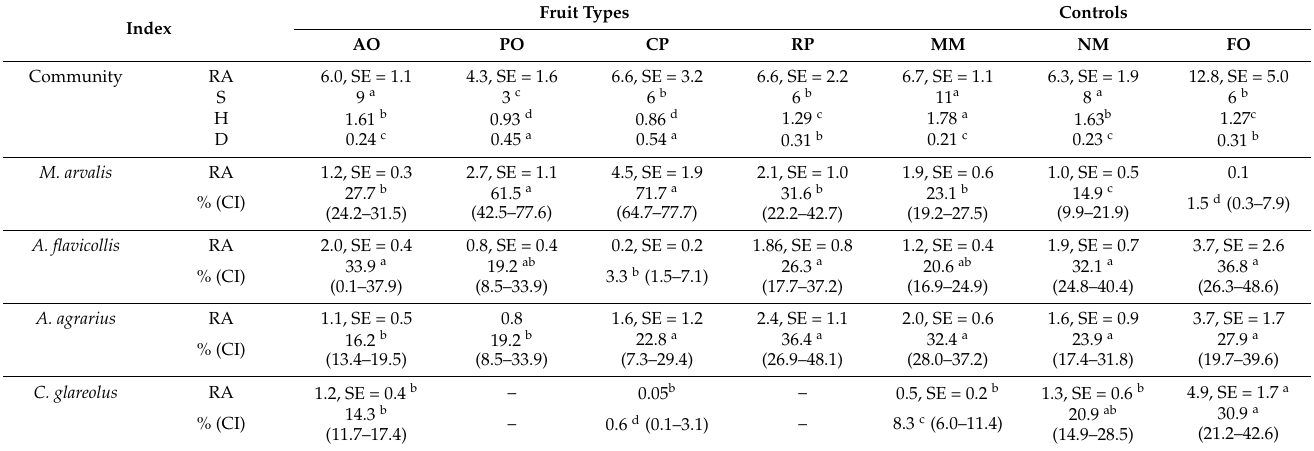
Table 4. Habitat-based differences of analyzed small mammal populations and species